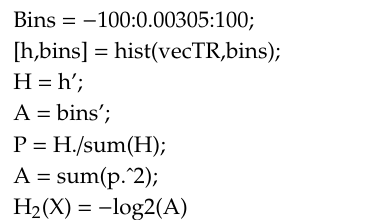
Figure A2. Delta entropy against signal-to-noise ratio (SNR) for Shannon’s and Renyi’s entropy.